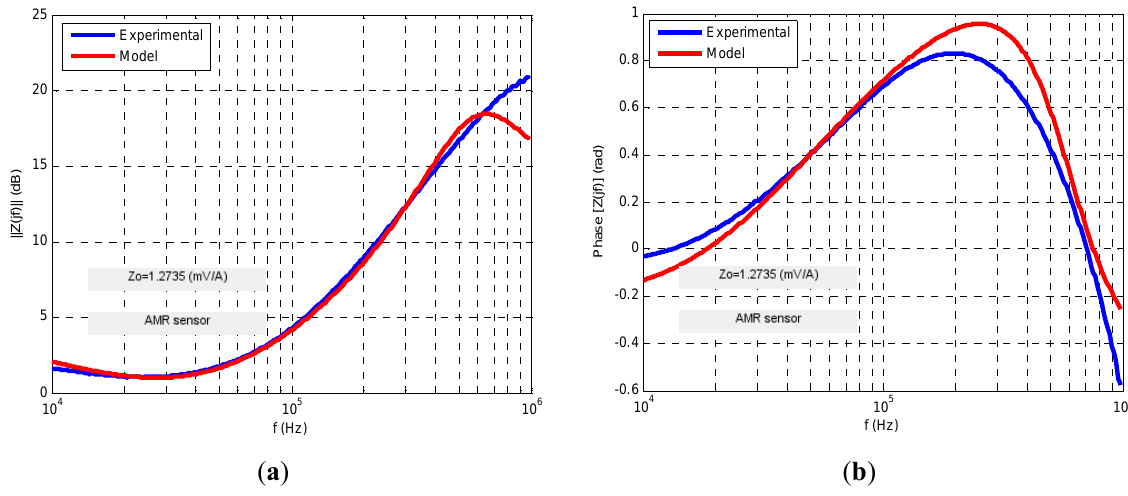
Figure 10. AMR sensor ac large-signal fractional